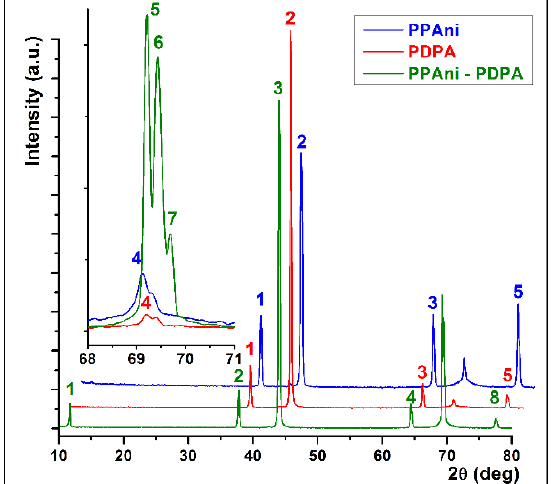
Figure 6. TEM images of PPAni-PDPA thin films at various magnifications, with scale bars ( a ) and ( b ) 1000 nm ( c ) 200 nm ( d ) 100 nm.